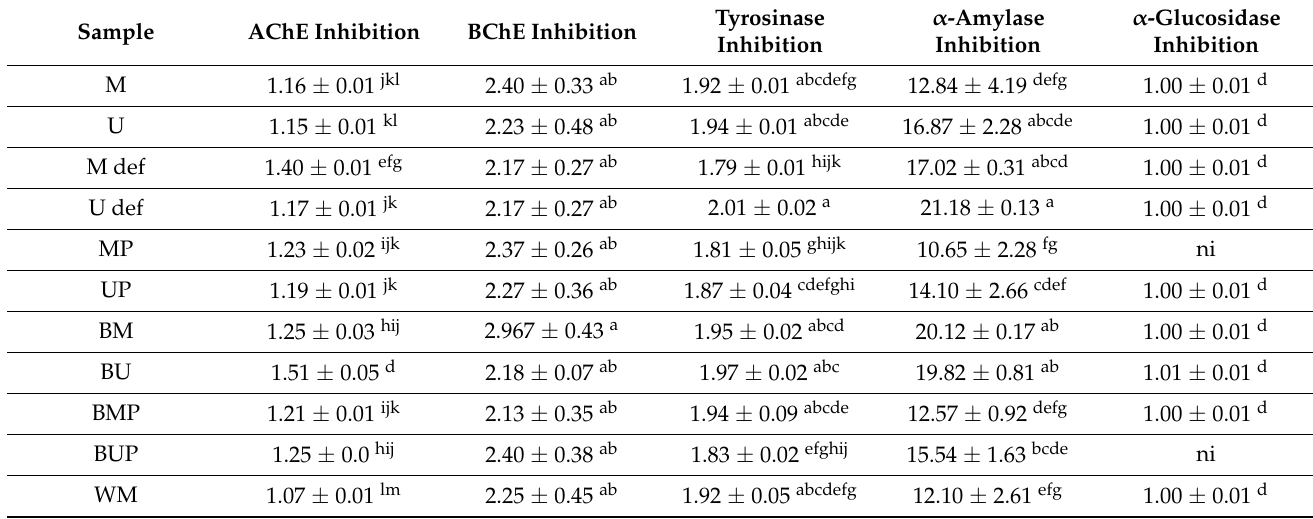
Table 2. Enzyme inhibitory results (IC 50 : mg/mL) of strawberry samples and standards against different enzymes.